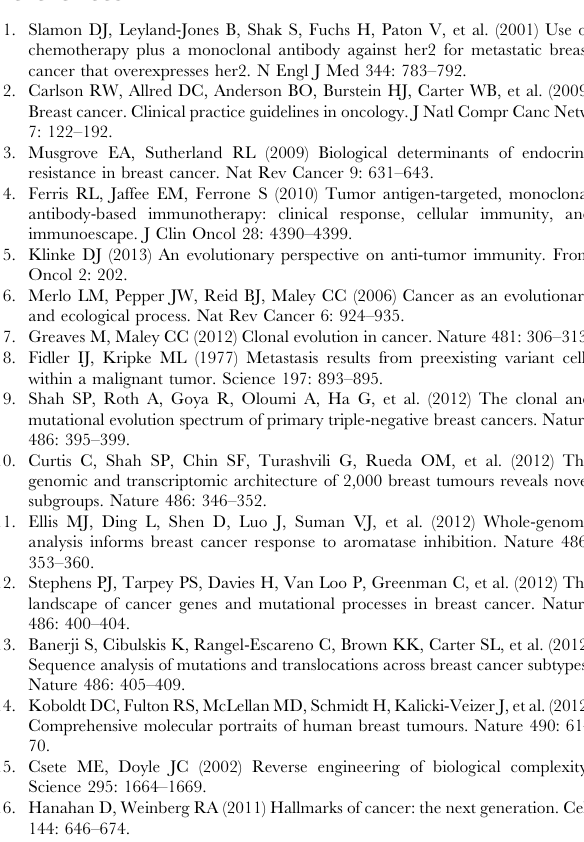
cell subset, as discussed in the main text. The mean values in posterior distributions of the null hypothesis in immune bias were estimated for each of the 1000 bootstrap resamples and shown as a distribution (gray shaded density distribution). Figure S7 Model-based inference of type 1 immune polarization is a better predictor of improved outcome than a random model of identical size. The x-axis denotes the hazard ratio of the clinical outcome associated with either a model representing type 1 T cell polarization (red squares) or a random model assembled from a random sample of the genes listed in Table 1 (box and whisker plot) obtained using a Cox proportional hazards model for the indicated time frames (1 Year, 3 Years, 5 Years, and 6 Years). The distribution in hazard ratio associated with the random model was assembled from 1000 bootstrapped replicates (box and whisker plot), where the median is represented by the vertical bar, the first through the third quartile is indicated by the box, and the whiskers indicate 6 2.7 standard deviations. Outliers are indicated by the circles and suggest that the distribution in hazard ratios are skewed towards lower hazard ratios. This is not surprising as the genes listed in Table 1 are resampled but genes involved in anti-tumor immunity are overrepresented. An important point here is that we are not regressing a random immune signature to clinical outcome within